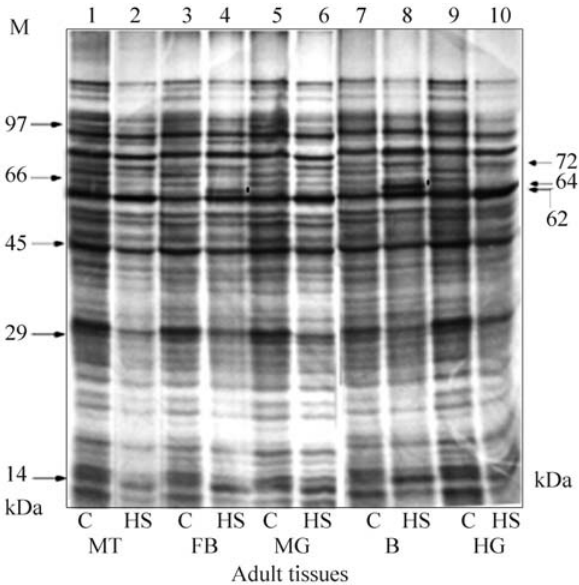
Figure 2A - Autoradiograph showing the expression patterns of the 62 kDa (HSP60) and 72 kDa (HSP70) proteins in control (C, 25 °C) and heat shocked (HS, 42 °C) Malpighian tubule (MT), fat body (FB), midgut (mg), brain (BG) and hindgut (HG) tissues of adult M. domestica (N = 15) . Dots in lanes 4 and 8 denote the 64 kDa band. Histogram showing densitometric optical density (OD) measurement of band intensity in the corresponding western blot lanes shown in (i)